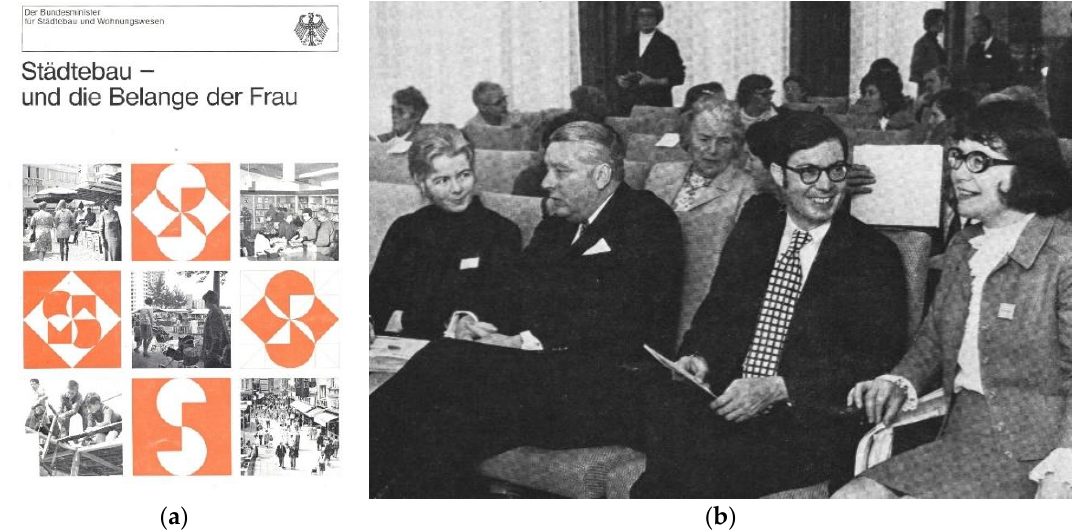
Figure 2. ( a ) Front cover of the book of events at the congress of Bad Godesberg 1970; ( b ) from right to left: Isolde Winter-Efinger, Lauritz Lauritzen, German politician, John R. Price, special advisor to president Nixon on Urban Affairs and Camila Odhnoff, the Swedish minister. Images used with permission.